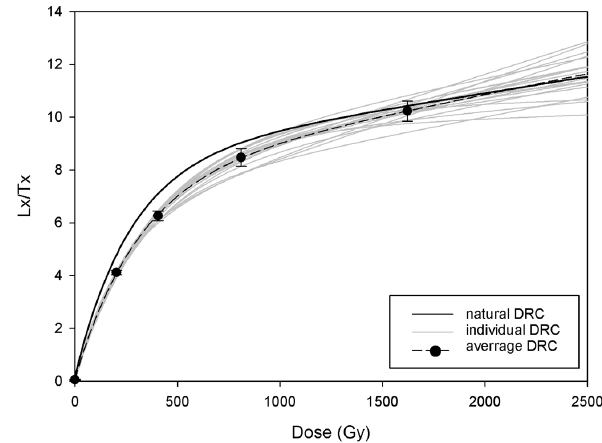
Fig. 8b. Comparison of the natural dose response curve (DRC) from Fig. 8a with the single aliquot regenerative DRCs of the aliquots used to construct the natural